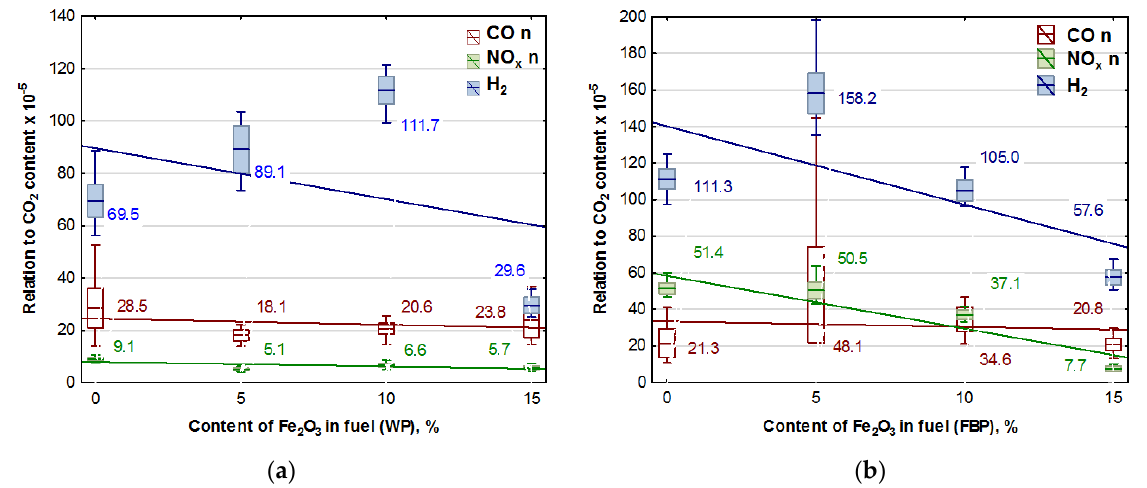
Figure 5. Graphs of CO, NO x , and H 2 content in flue gases (coordinated to CO 2 emission values) in dependence on the Fe 2 O 3 content in pellets: ( a ) Wood pellets (WP); and ( b ) Furniture board pellets (FBP). Table 7. Regression equations for the trend line of the dependence of CO, NO x , and H 2 emissions from CO 2 content and p -values.